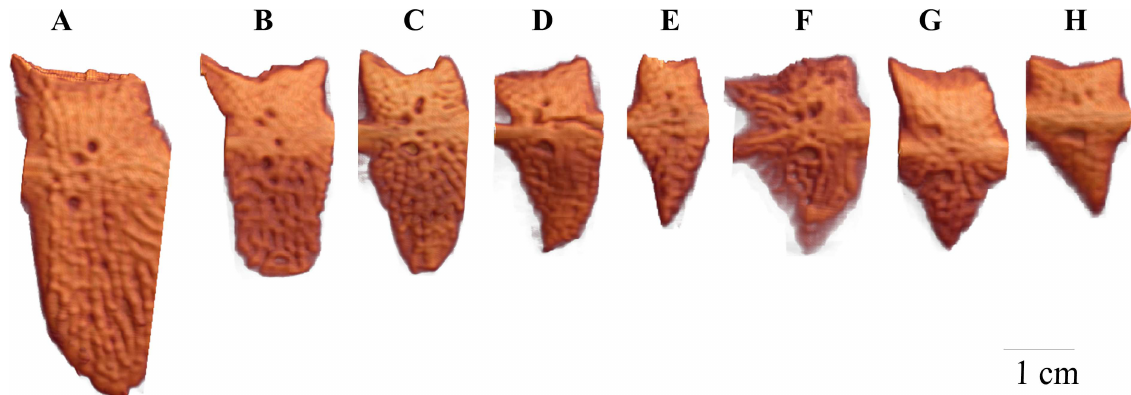
Fig 4. Representative images for the populations of the isolated LP 4 from the Barents Sea (A), Gardatj ø rna(B), from Engervann; complete plate morph (C), partial plate morph (D), low plate morph (E) and from Asd ø ltjern; complete plate morph (F), partial plate morph (G) and low plate morph (H). Lateral plate size is not corrected for fish length.